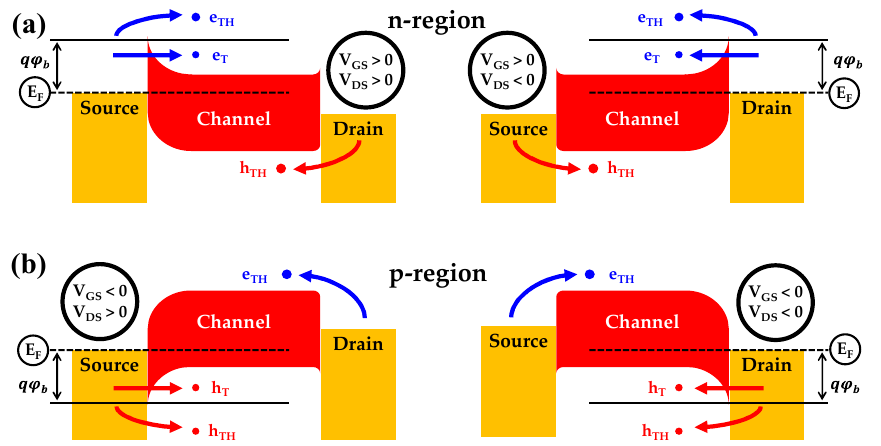
Figure 6. Band diagram of MWA- and RTA-treated ambipolar NiSi x SB-TFTs in schematic form based on VGS and VDS (a) n-region operation (b) p-region operation.